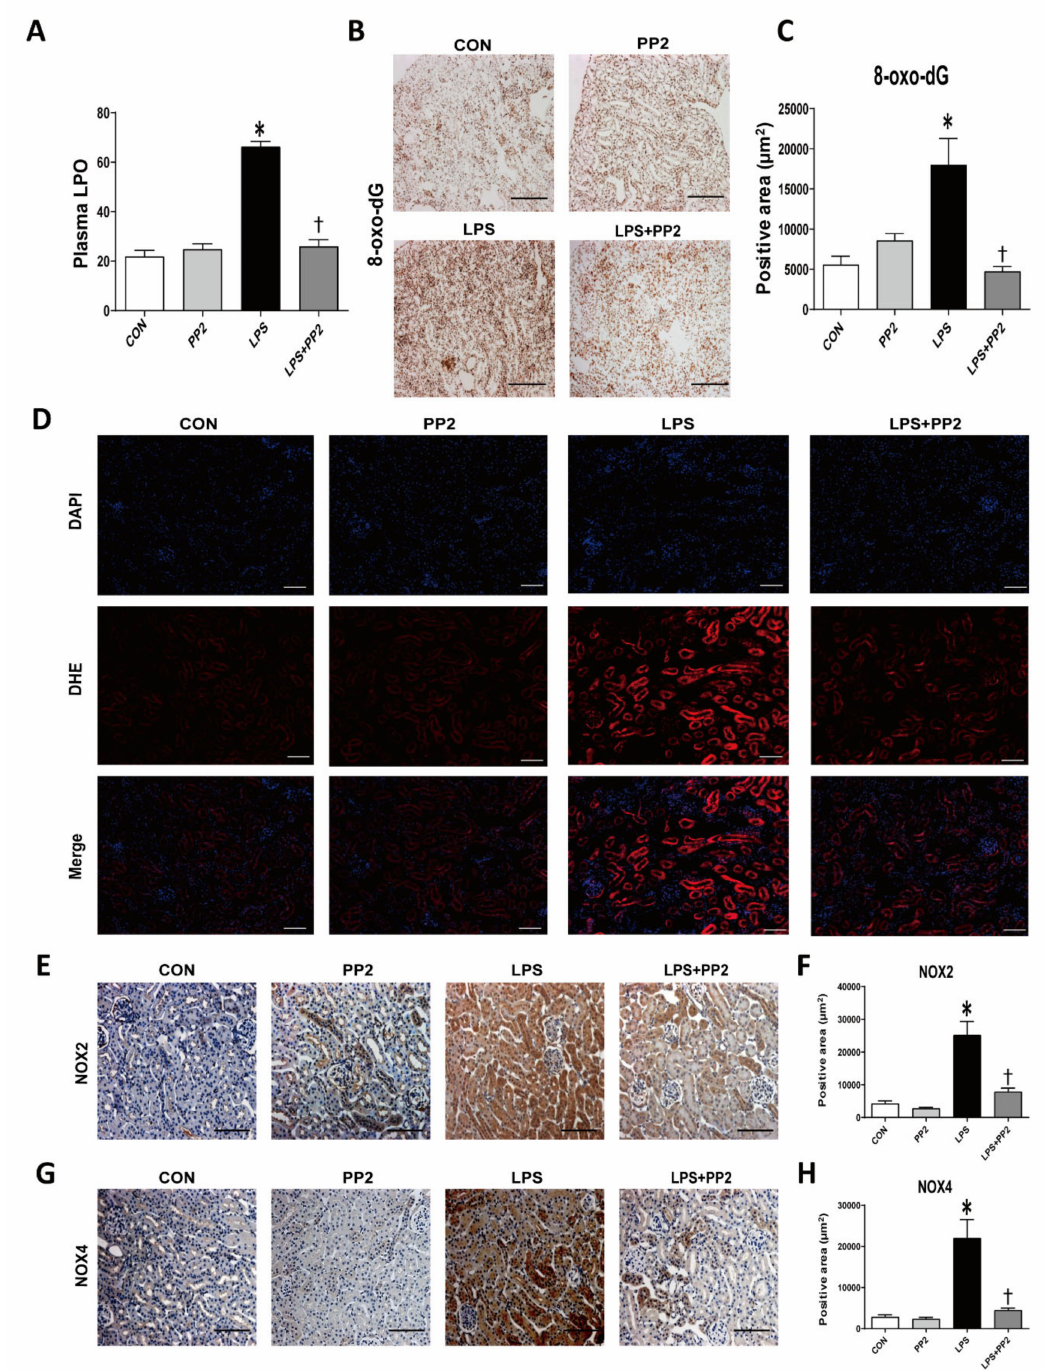
Figure 4. PP2 attenuates kidney oxidative stress in the LPS-induced AKI mice. ( A ) Plasma lipid hydroperoxide (LPO) ( µ M). ( B , C ) Para ffi n-embedded kidney sections were stained with 8-oxo-dG (1:200; original magnification: 100 × ; scale bar: 200 µ m) antibody. ( D ) Frozen kidney sections were stained with DHE dye (5 µ M for 10 min; original magnification: 100 × ; scale bar: 50 µ m). ( E – H ) Para ffi n-embedded kidney sections were stained with Nox2 (1:500; original magnification: 200 × ; scale bar: 100 µ m) and Nox4 (1:400; original magnification: 200 × ; scale bar: 100 µ m) antibodies. Data are presented as mean ± SE of 6–8 mice. * p < 0.05 vs. control, † p < 0.05 vs.